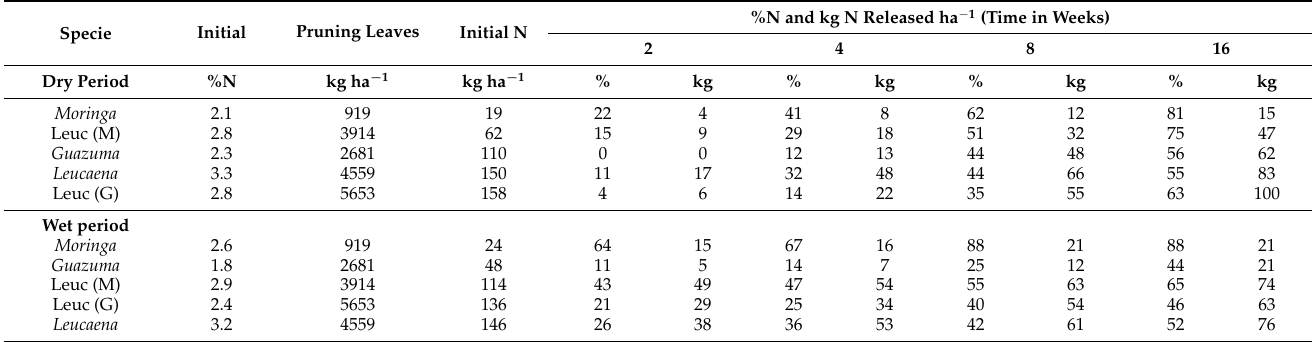
Table 5. Nitrogen concentration and N (kg ha − 1 ) soil inputs from decomposed leaves in